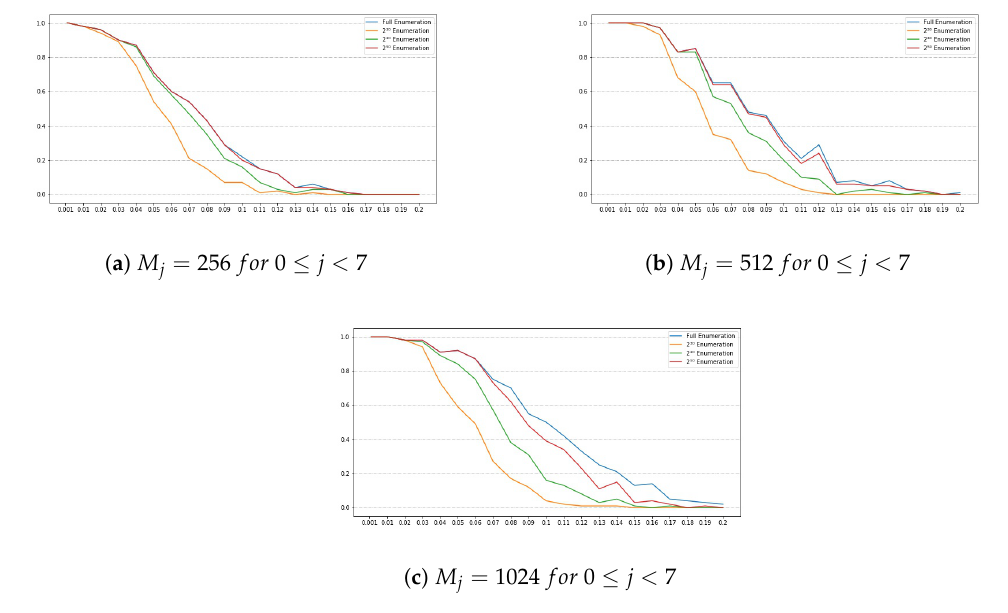
Figure 1. Success rates for the SIKE parameters SIKEp434 for α = 0.001. The y -axis denotes the success rate, while the x -axis denotes β